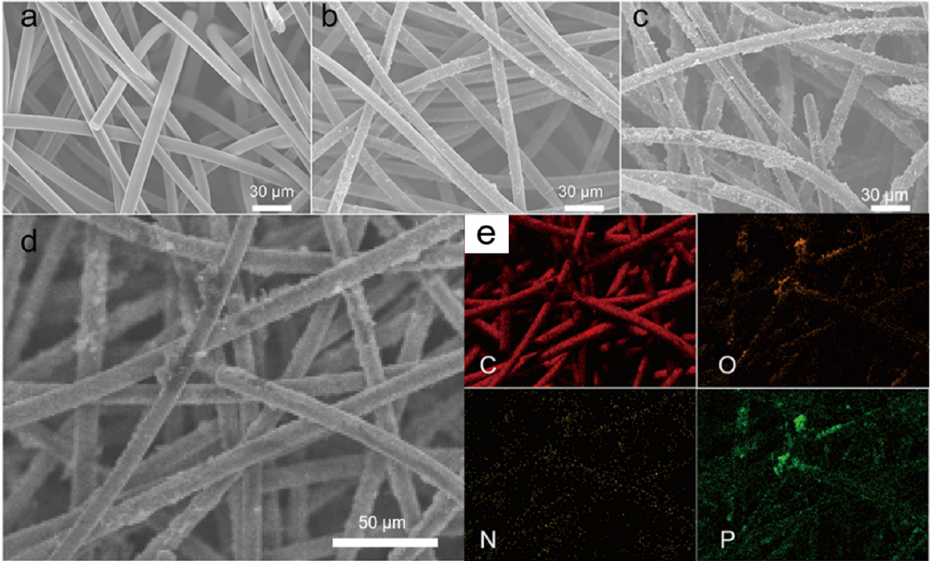
Figure 4. The SEM images of the ( a ) GF, ( b ) GF@CG-900, ( c ) GF@PCNs-900 and ( d ) the morphology and ( e ) element distribution of GF@PCNs-900.